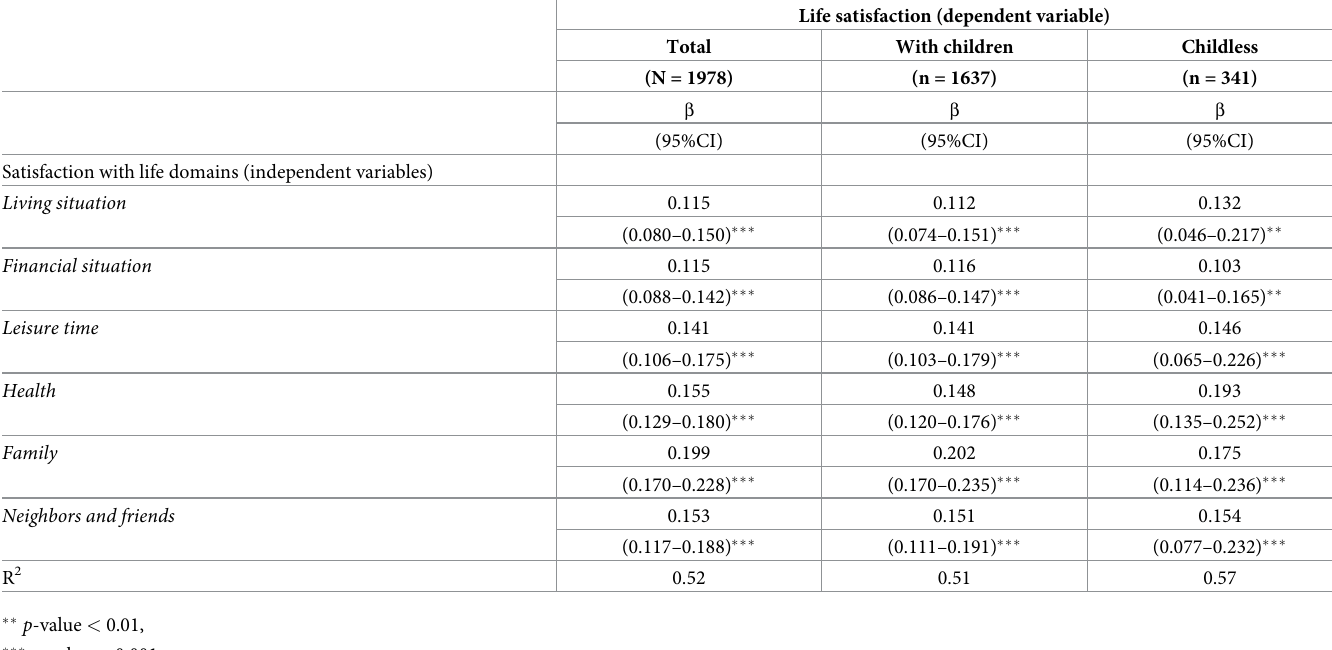
Table 3. Association of life satisfaction and satisfaction in life domains. Linear regression adjusted for sex and age.